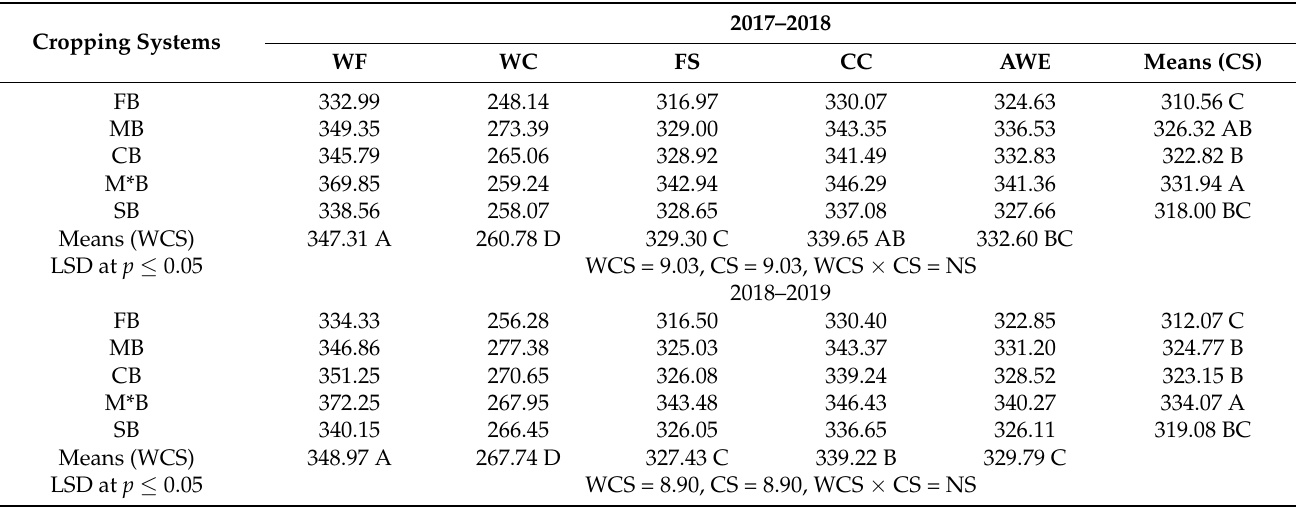
Table 7. Influence of different barley-based cropping systems on dry biomass yield (g m − 2 ) under various weed management